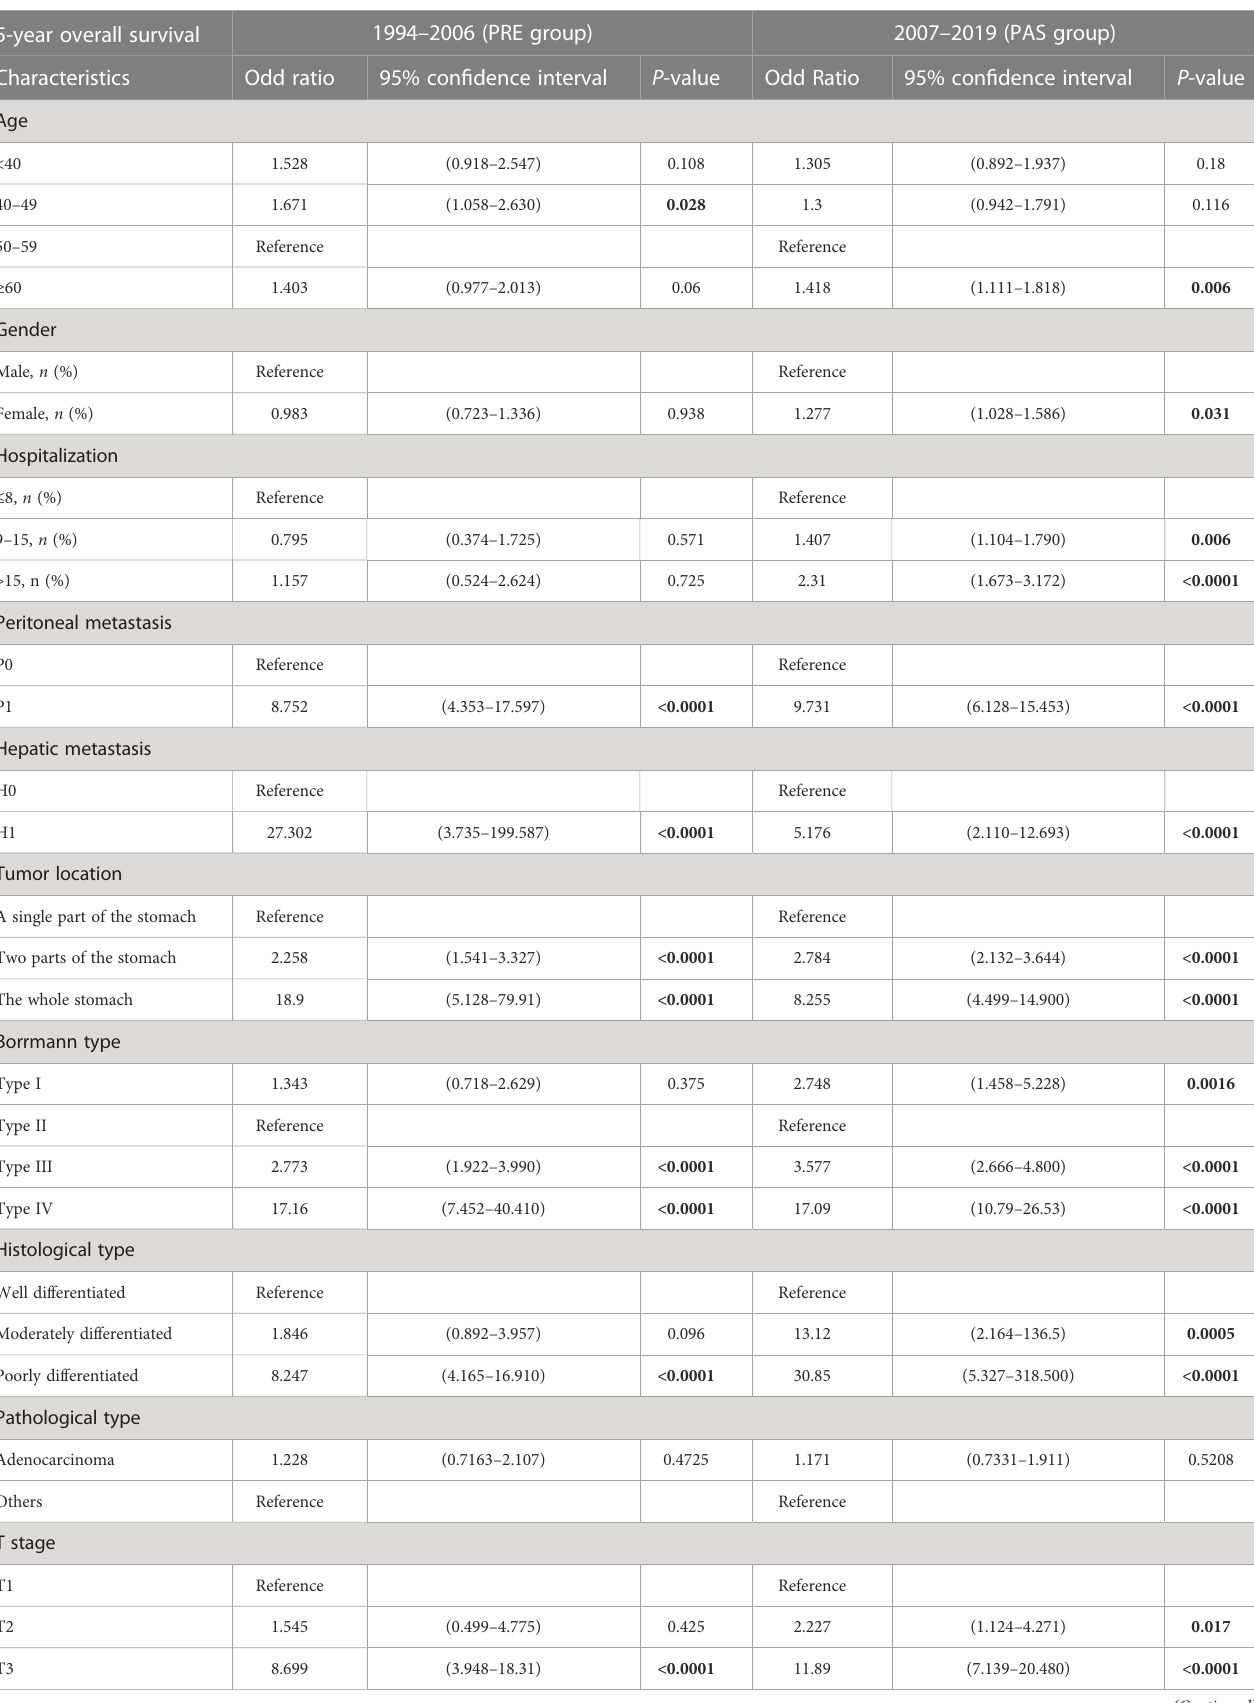
TABLE 4 Comparison of 5-year overall survival characteristics between the PRE group and the PAS